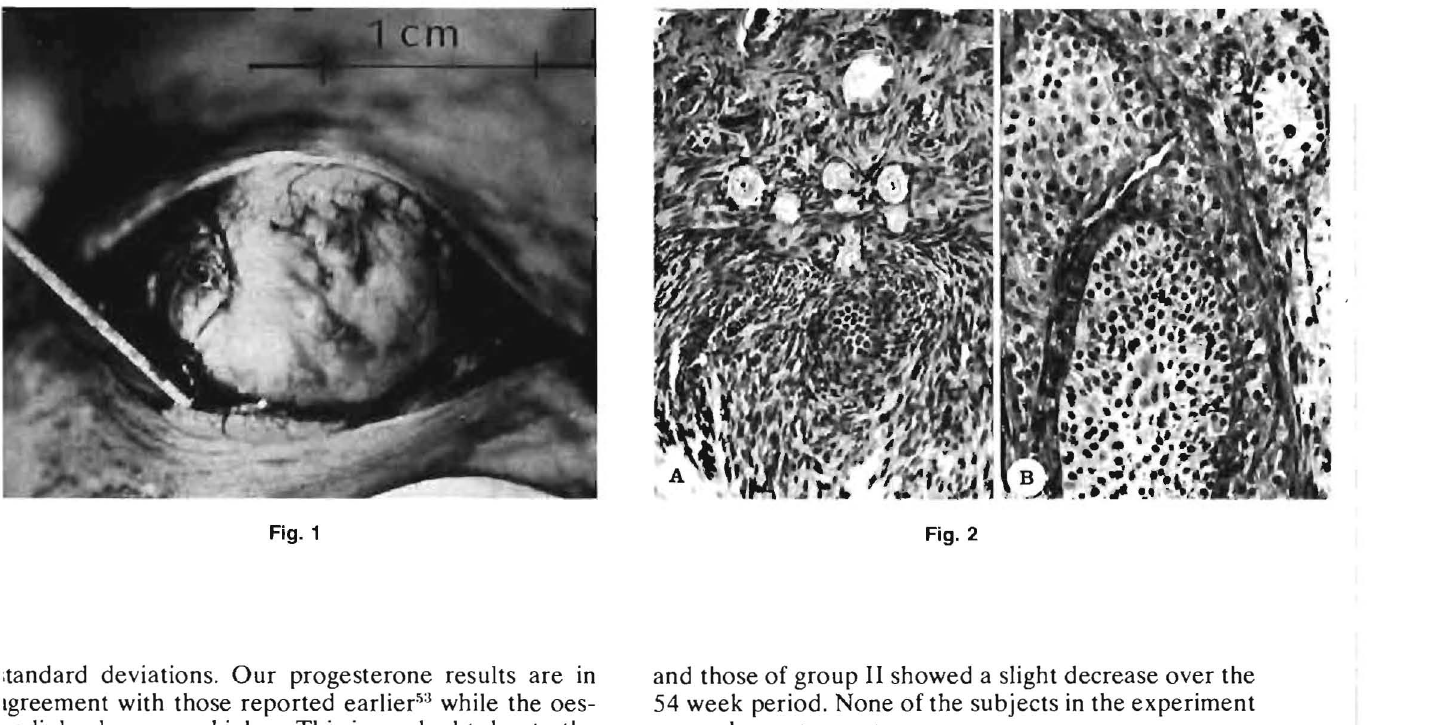
Table 1: PERIPHERAL SERUM LEVELS OF ESTRADIOL AND PROGESTERONE Estradiol